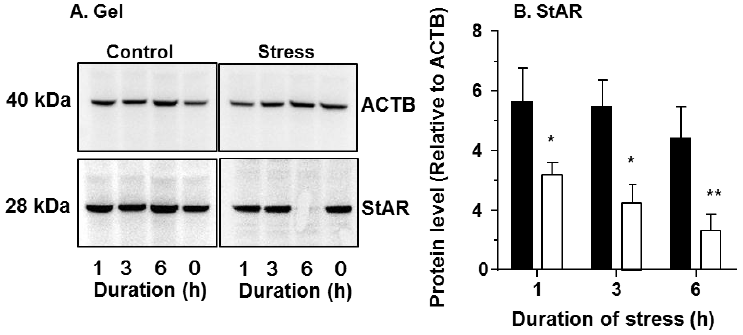
Figure 5. Protein levels of steroidogenic acute regulatory protein (StAR) of testes from control and stressed rats during the course of stress (1 to 6 h). ( A ) The representative gel; and ( B ) The semi-quantitative levels of StAR, with control (black bar) and immobilization stress (white bar). Protein levels were adjusted by β-actin (ACTB). Mean ± SEM ( n = 6). * , ** indicate significant difference compared to the control at each time point at p < 0.05 and p < 0.01, respectively.